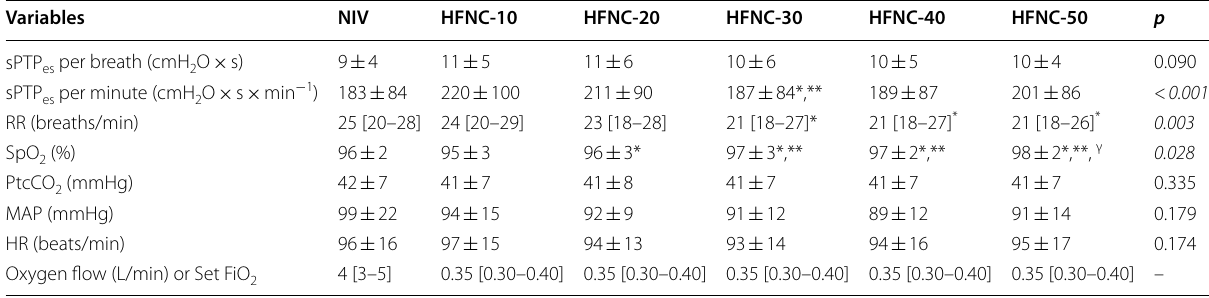
Continuous variables were presented as mean SD or median [interquartile range] and categorical variables were presented as absolute value (%) ± HFNC high-flow nasal cannula, HR heart rate, MAP mean arterial pressure, NIV non-invasive ventilation, sPTP es , simplified esophageal pressure–time product, PtcCO 2 , transcutaneous carbon dioxide pressure, RR respiratory rate, SpO 2 , oxygen saturation * Indicates p < 0.05 compared with HNFC-10, ** Indicates p < 0.05 compared with HFNC-20, γ Indicates p < 0.05 compared with